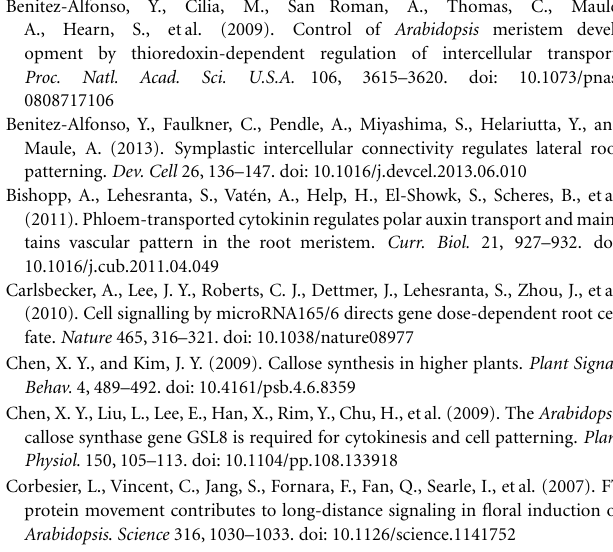
The color codes highlight miRNA concentrations in the endodermis and the vascular tissues, before (A) and after induction (B) .The miRNA signals in the endodermis of estradiol-treated plants are higher than the mock-treated plants whereas opposite pattern is seen in the vascular tissues. (C,D) The utility of icals3m in analyzing the shoot-to-root transport of cytokinins in Arabidopsis. 14 C-labeled N6-benzyladenine (BA) was applied to the hypocotyls (shown by red arrow) and accumulation of the radio labeled isotope was analyzed in the root tips (highlighted by red box). (C) In wild-type roots, a high level of radioactive signal is seen in the root tip which is significantly reduced upon blocking the symplastic connectivity in the phloem tissues by expressing icals3m under APL promoter ( D ; Bishopp etal.,